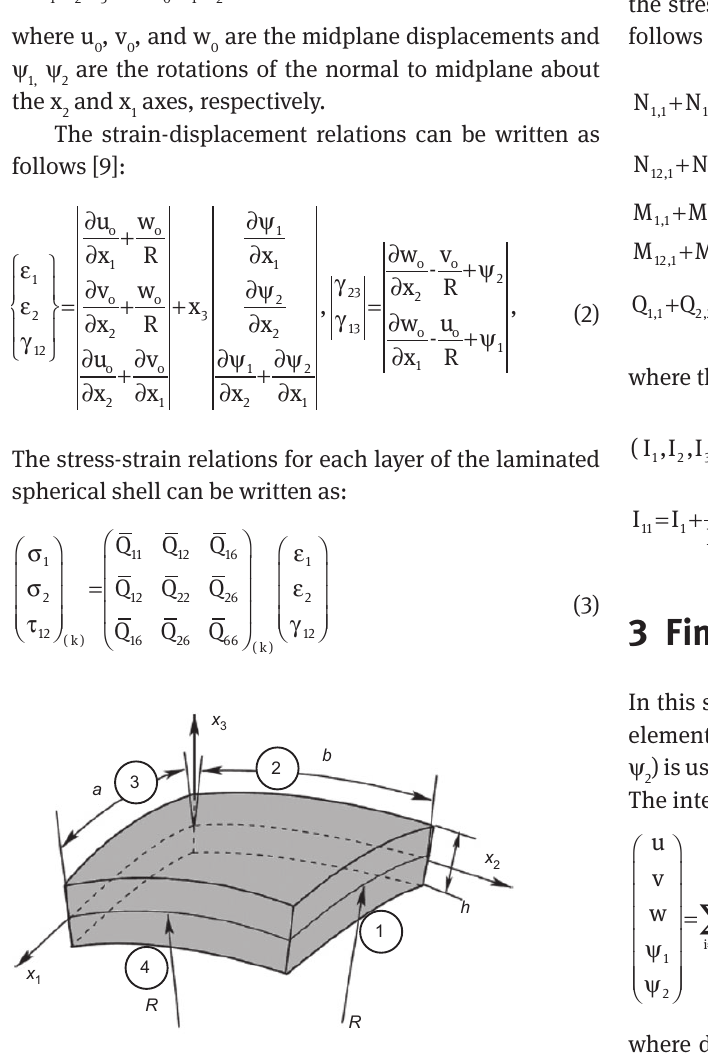
Figure 1 Geometry of a spherical shell [9]